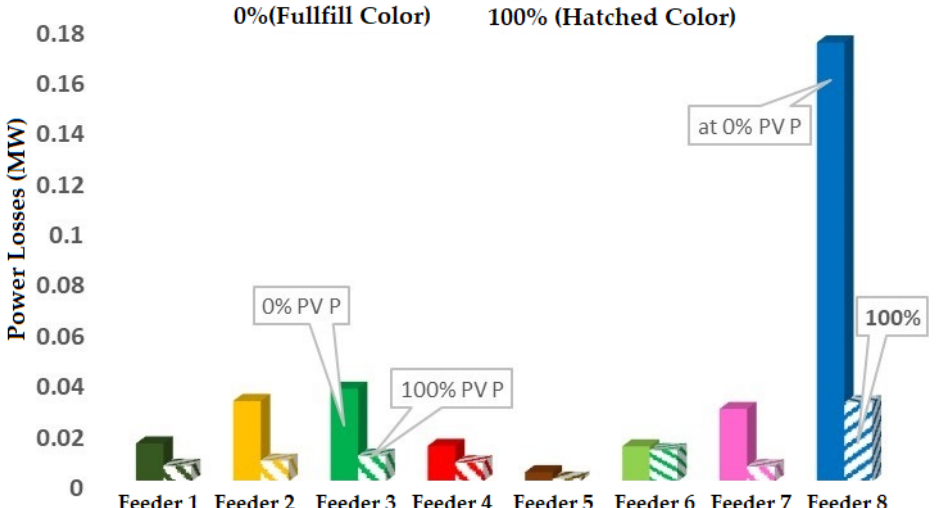
Figure 5. Power loss among feeders at peak load for 0% and 100% PV penetration.